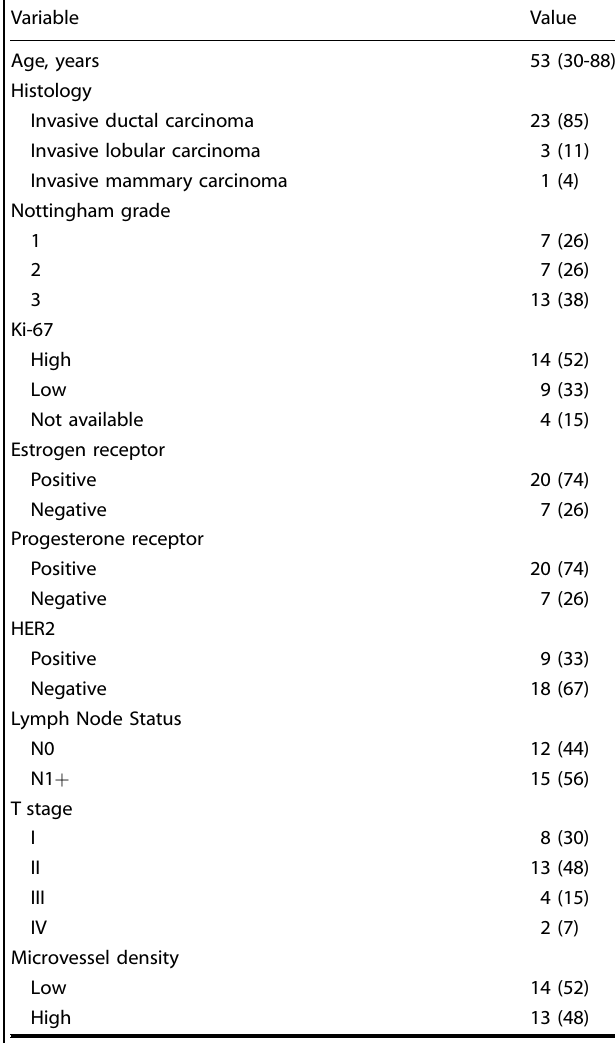
Table 1. Patient and tumor